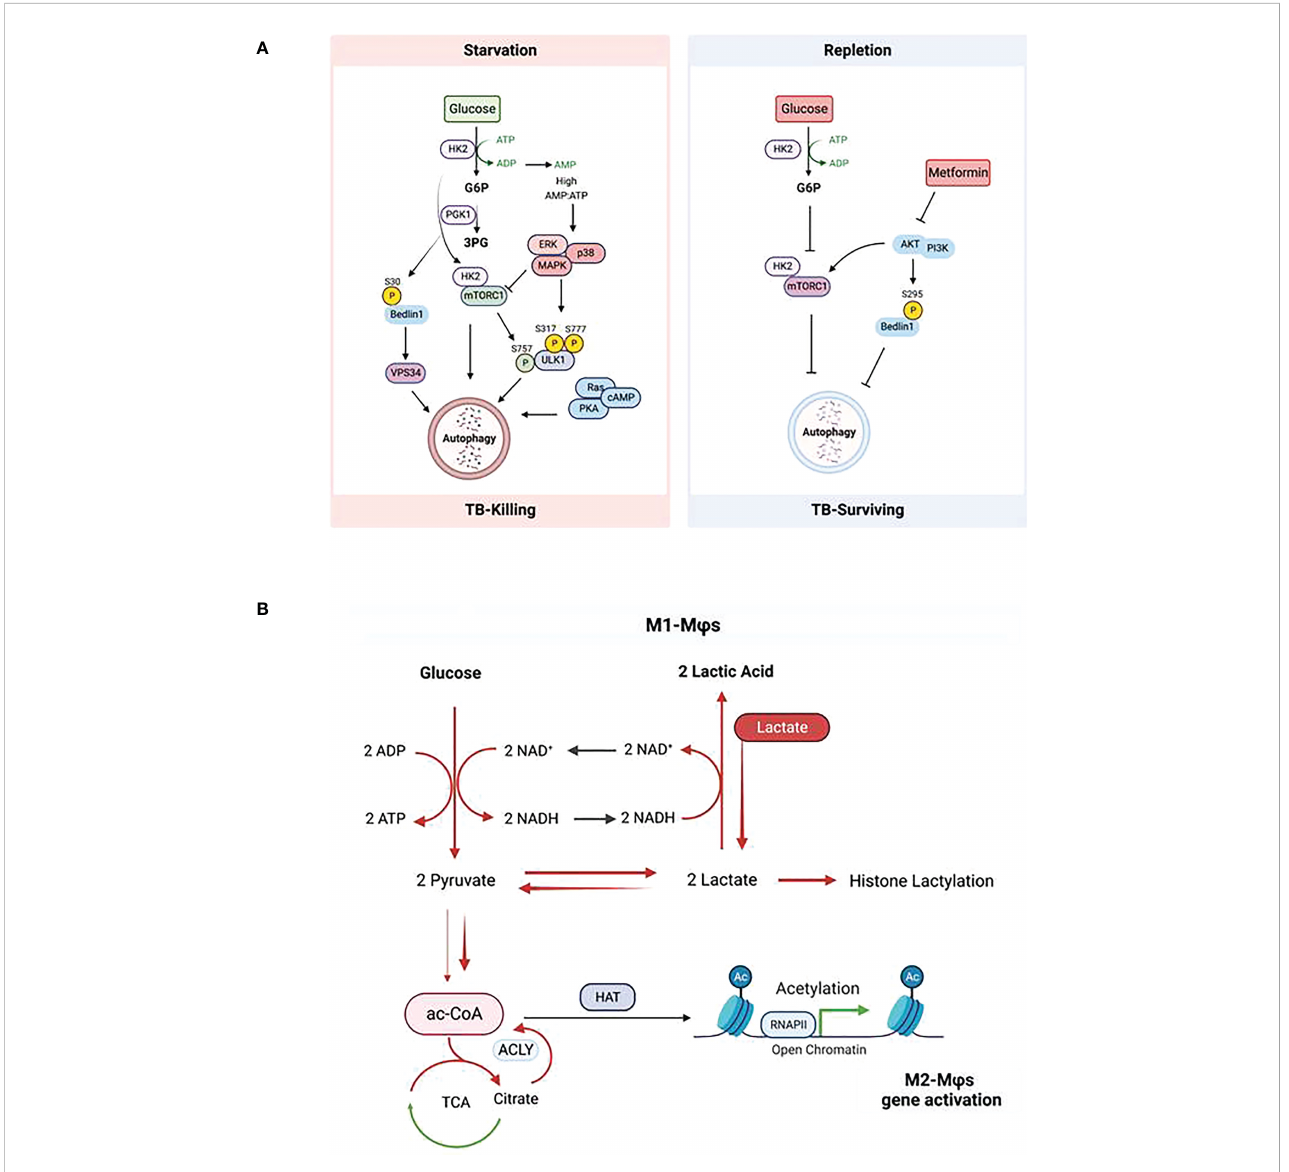
FIGURE 3 Impact of glucose metabolism on autophagy in macrophages during tuberculosis. (A) Regulation of autophagy by glucose homeostasis ( Left : glucose starvation; Right : glucose repletion) dependent metabolic sensor kinases. Description of the scheme is referred to the text. (B) Glycolysis-promoted histone lactylation and acetylation during macrophage polarization. Upregulation of glycolysis in M1-M f s increases lactate production from pyruvate; however, excess of lactate provided exogenously pushes the equilibrium of the conversion between pyruvate and lactate further to the synthesis of citrate from pyruvate and the former is broken up to acetyl -CoA by ACLY; this results in the elevation of both global histone acetylation and acetylation of chromatins associated with the promoters of genes which promote polarization towards M2-M f